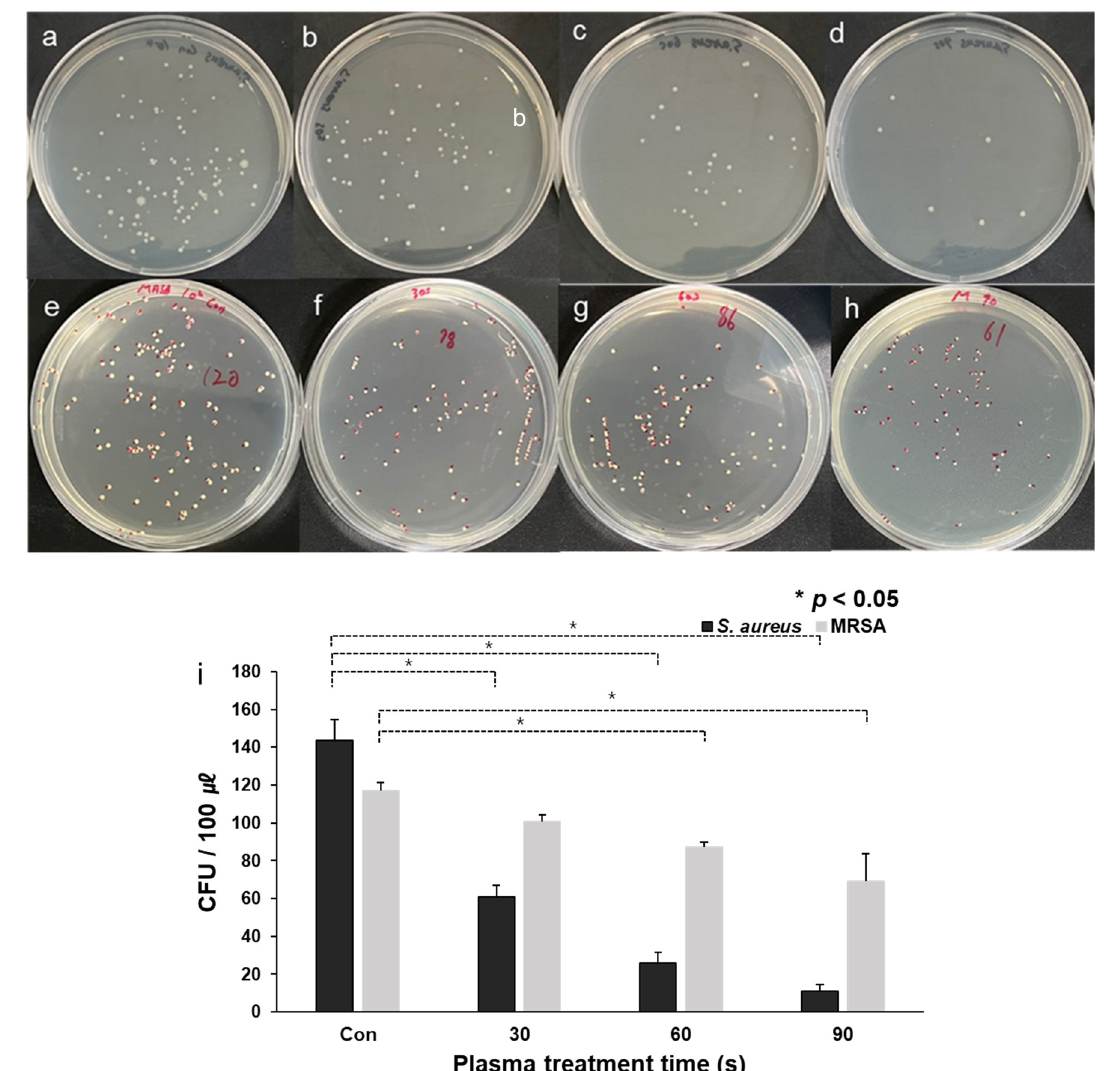
Figure 4. Colonies of ( a – d ) S. aureus and ( e – h ) MRSA on the LB agar plate with a diameter of 100 mm after CAPMP treatment on S. aureus or MRSA suspension. ( a , e ) Control applied with solely Ar gas for 90 s or ( b – d , f – h ) with plasma discharge for ( b , f ) 30, ( c , g ) 60, or ( d , h ) 90 s; ( i ) average and standard deviation of the colonies for S. aureus or MRSA with respect to the CAPMP treatment time ( n = 3), *: p < 0.05 by t -test between the groups.